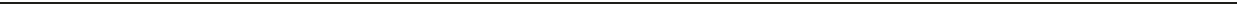
Fig. 3 Tumor burden alters the fate of myeloid progenitors. a CD45.1 + Lin − Sca1 − cKit + MPs were transferred into mice bearing 1.0 cm diameter orthotopic PyMT-B6 tumors or tumor-free controls. BM was analyzed for CD45.1 + populations after 2 weeks. BM MDPs, CDPs, pre-DCs, CD24 + cDC1s, and granulocytes, and blood granulocytes displayed as frequency of CD45.1; n = 5/group. b CD45.2 + Lin − Sca1 − cKit + MPs, CD45.2 + MDPs, and CD45.2 + CDPs were isolated from end-stage orthotopic PyMT-B6 tumor-bearing or tumor-free donors. Progenitors were cultured on CD45.1 + BM feeder culture for 5 days in the presence of 100 ng/ml Flt3L. Final cultures were analyzed for cDC1 (Live CD45.2 + CD45.1 - MHCII + CD11c + Sirp α - CD24 + ). End stage is de fi ned in the Methods. Data are representative of three independent experiments consisting of three wells per condition. GMPs, MDPs, and CDPs were sorted from mice bearing end-stage orthotopic PyMT-B6 mammary tumors and tumor-free controls. c GMPs, MDPs, and CDPs were analyzed by RT-qPCR. d MDPs and CDPs were analyzed by microarray. Cluster analysis was performed with a differential genes list generated from gene with 1.5-fold at p < 0.05 and FDR q < 0.05 in MDP or CDP comparison from PyMT-B6 tumor bearing to tumor free. Four samples, each consisting of two mice, were analyzed per group. e MDPs and CDPs were isolated from PyMT-B6 tumor-bearing mice or tumor-free controls. Progenitors were adoptively transferred into BATF3 − / − mice. PyMT-mCh-OVA was implanted after 3 days into wild-type mice, BATF3 − / − mice without adoptive transfer, and BATF3 − / − mice with adoptive transfer from tumor-free or tumor-bearing mice. Tumor growth was monitored. Error bars represent mean + / − s.e.m.; * p < 0.05, ** p < 0.01, *** p < 0.001 by unpaired two-sided Student ’ s t test or two-way